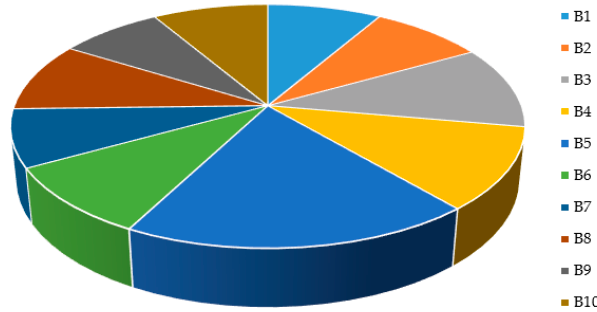
Figure 5. The objective weights of each evaluation indicator.